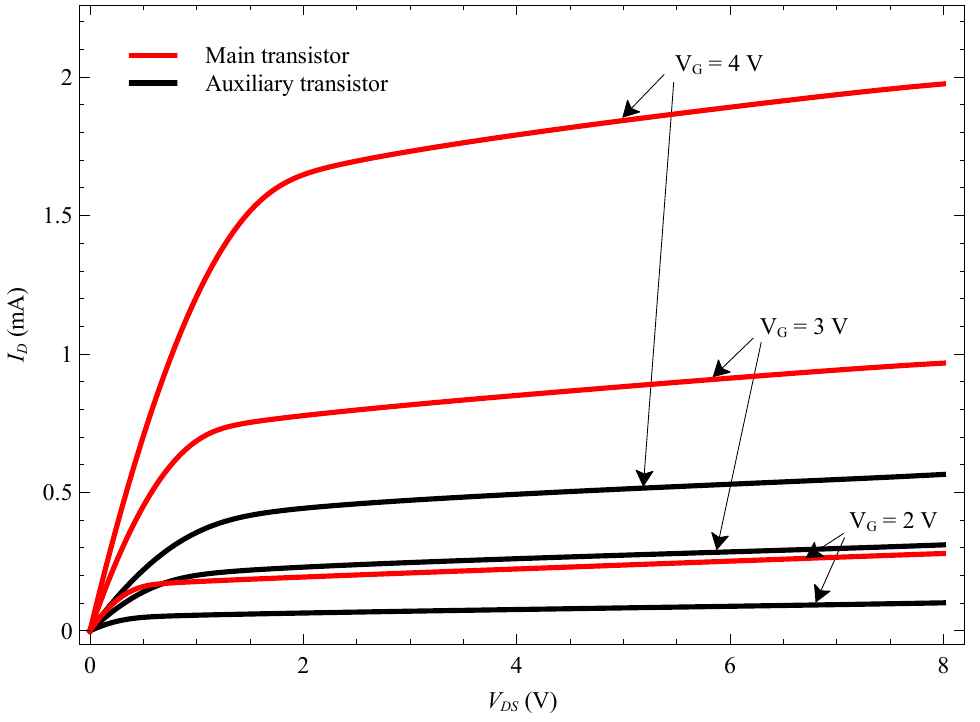
Figure 6. Output characteristics of the main and auxiliary